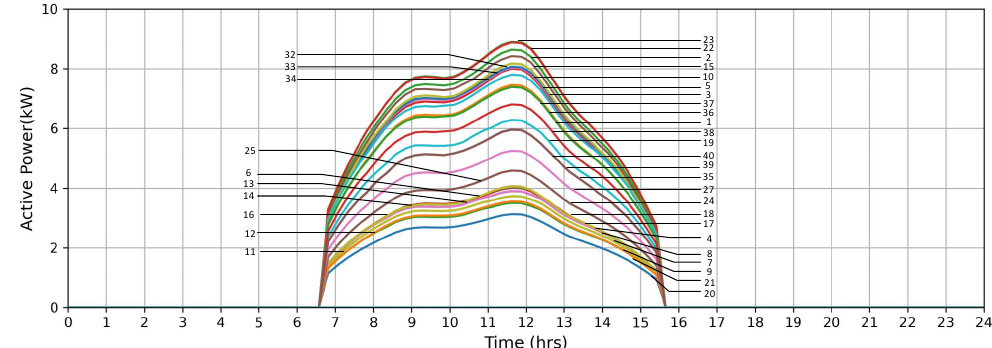
Figure 9. Active power variation of all the PV units during the assessment period.